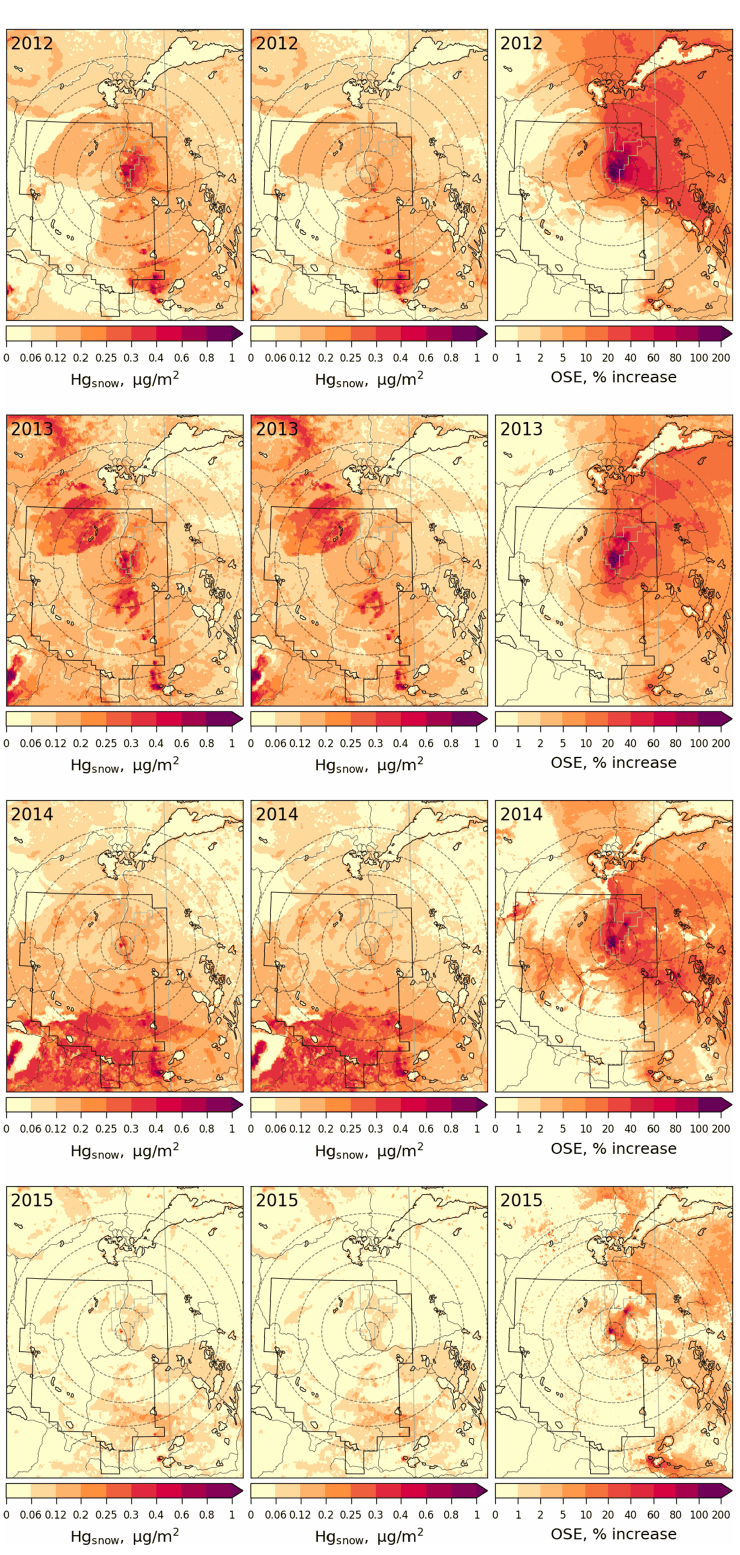
Figure 15. Seasonally accumulated Hg loadings in snow with all Hg emissions (left) and without Athabasca oil sands Hg emissions (middle) and enrichments (%) in seasonally accumulated Hg loadings in snow due to Athabasca oil sands Hg emissions (OSE, right) in 2012–2015. The AOSR is marked as an approximate rectangle, and concentric distance circles are at 20, 50, 100, 150, 200 and 250km from